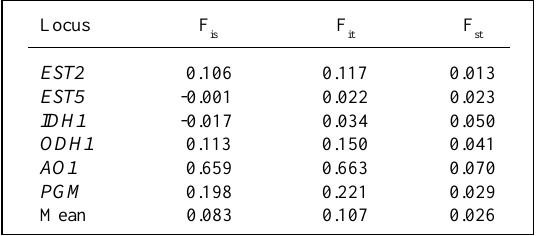
Table IV - Analysis of intra- and interpopulation genetic structure by the Wright F-statistic in natural populations of Anopheles darlingi . Locus F is